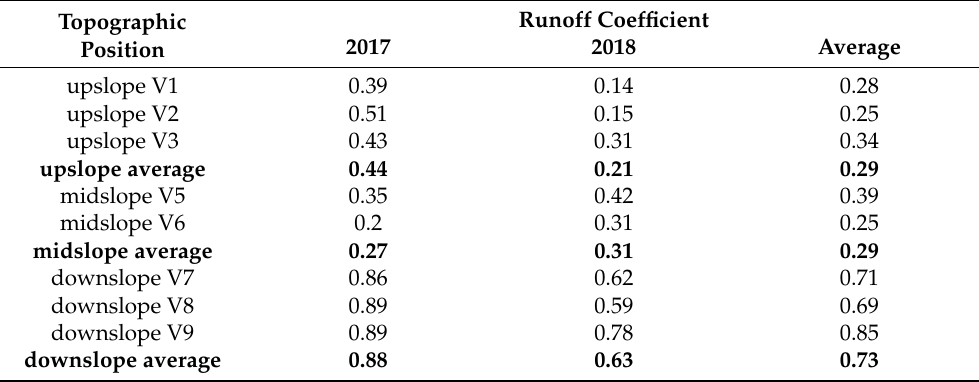
Table 2. Average annual runoff coefficients during the rain phase for the upslope, midslope, and downslope topographic positions in the Debre Mawi watershed in 2017 and 2018. The average runoff coefficient for each slope position was obtained by averaging all storms on the three fields for the slope position. Runoff started on 29 June 2017 and 8 July